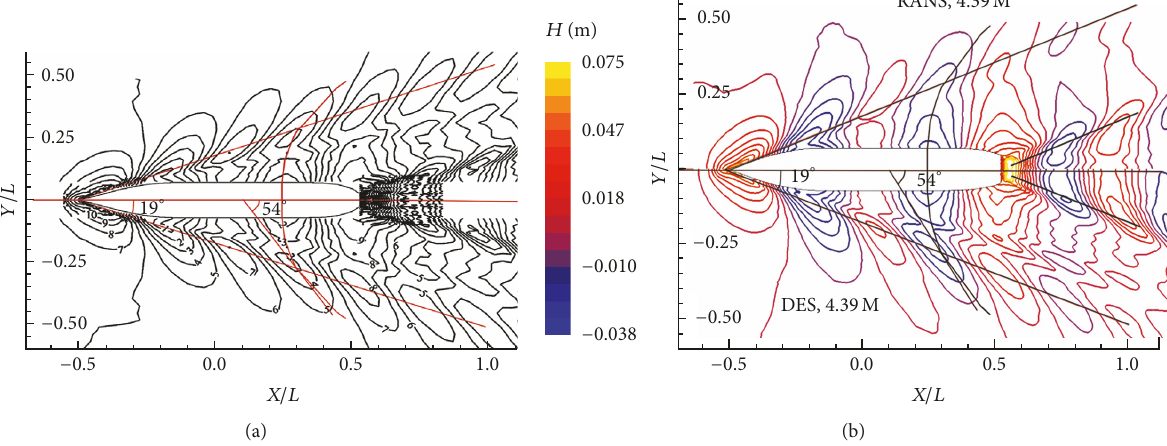
Figure 7: Measured (a) and predicted ship waves by URANS and DES (b) in the finest mesh case (Fn = 0.26 ).